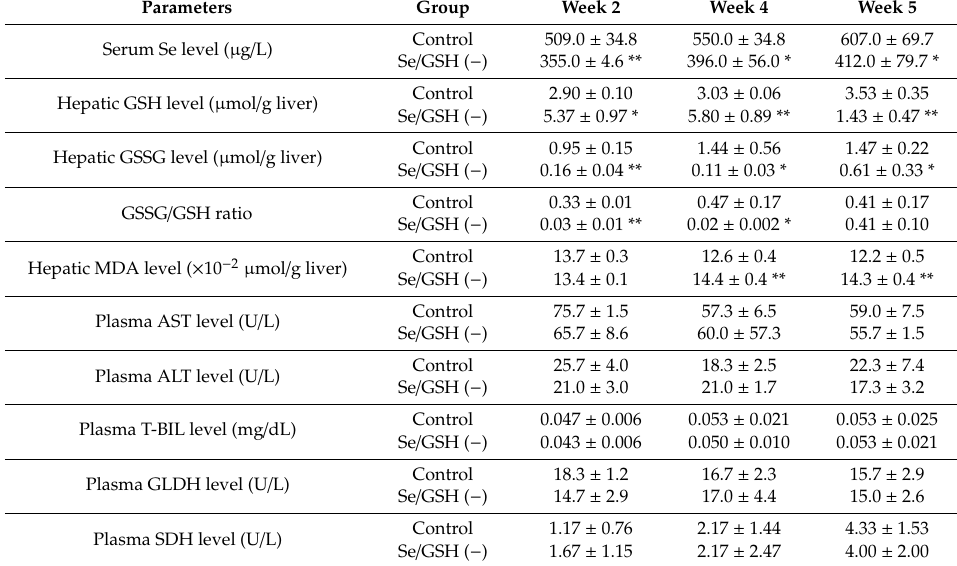
Table 1. The results of the profiling of Se / GSH-depleted rats.